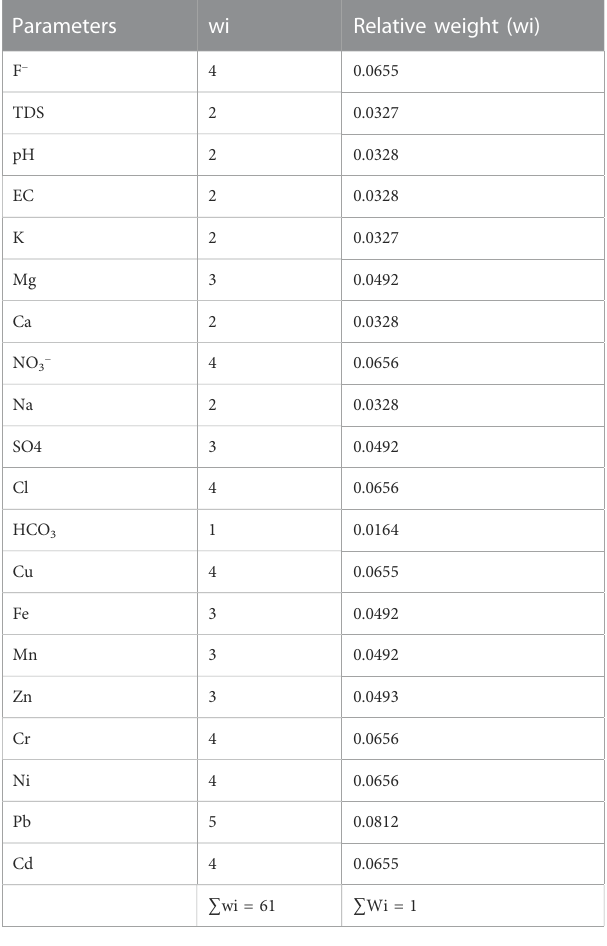
TABLE 1 Relative weights of parameters used in PIG and WQI evaluation.